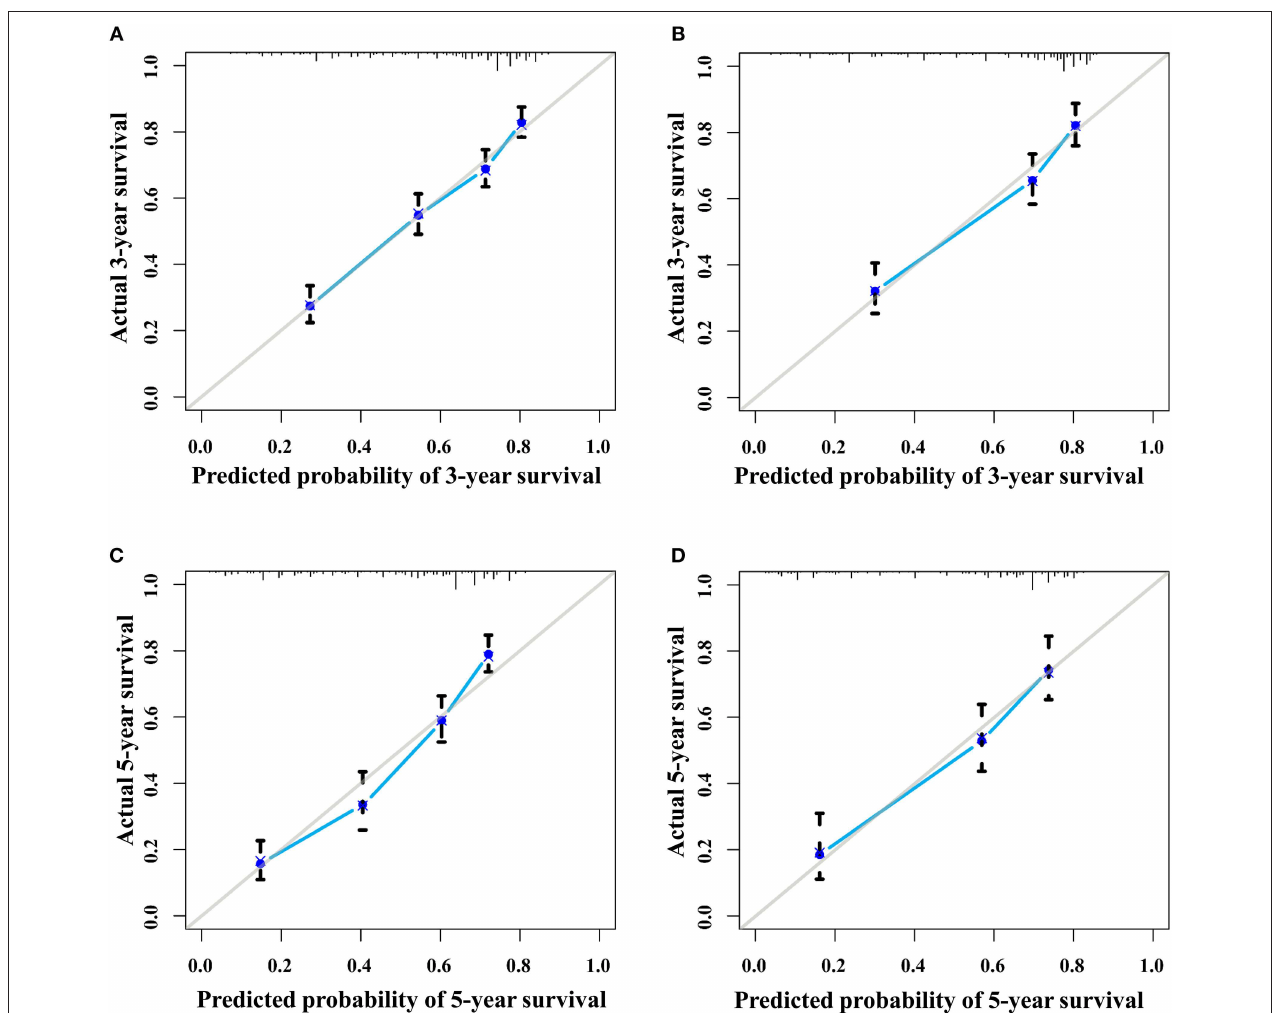
FIGURE 5 | The calibration curves of the nomogram for 3- and 5- year survival probabilities. (A) Three-year survival for the training group. (B) Three-year survival for the validation group. (C) Five-year survival for the training group. (D) Five-year survival for the validation group.